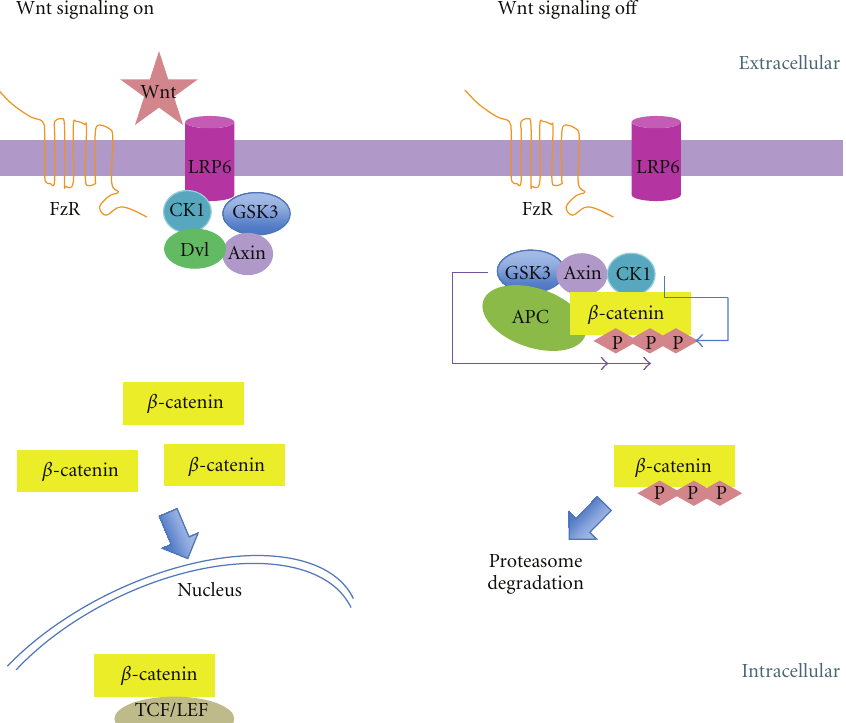
Figure 2: Canonical Wnt signaling and GSK3 regulation. Wnt activation through Frizzled receptor (FzR) induces destabilization of the protein complex composed of axin, adenomatous polyposis coli (APC) protein, β -catenin, casein kinase (Ck1), and GSK3, which results in GSK3 inhibition leading to the induction of β -catenin/TCF target gene expression. When Wnt signalling is o ff the GSK3/axin complex is not inhibited and β -catenin phosphorylated and is degraded by the proteasome